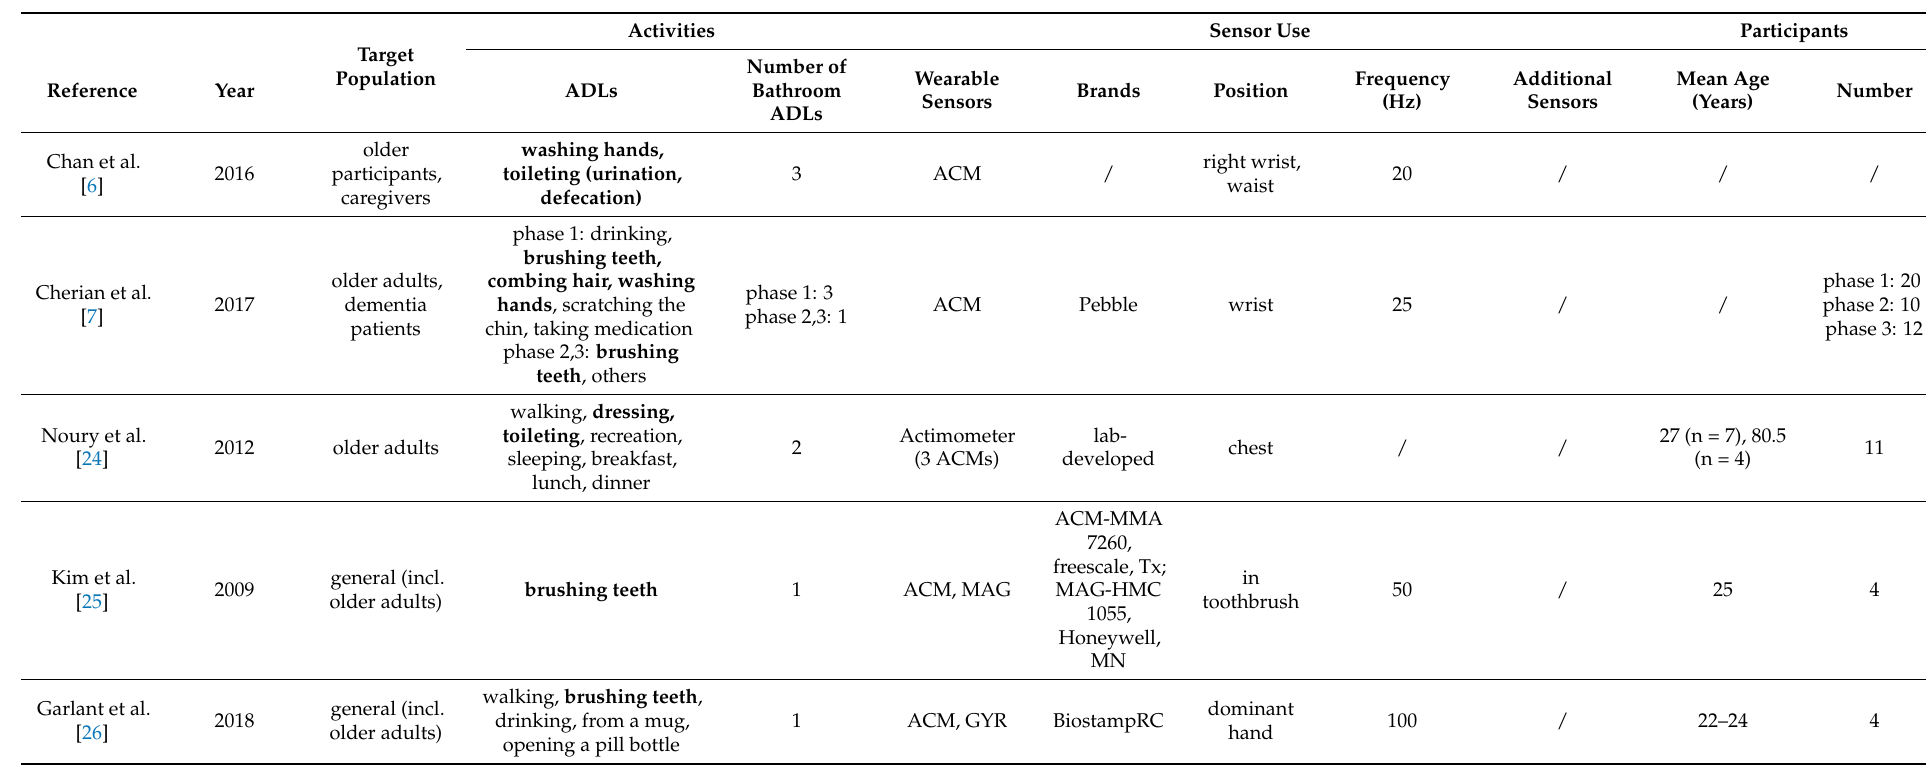
Table 2. Overview of extracted data from papers regarding target population, activities, sensor use, participants, setup of the experiment, feature extraction and recognition